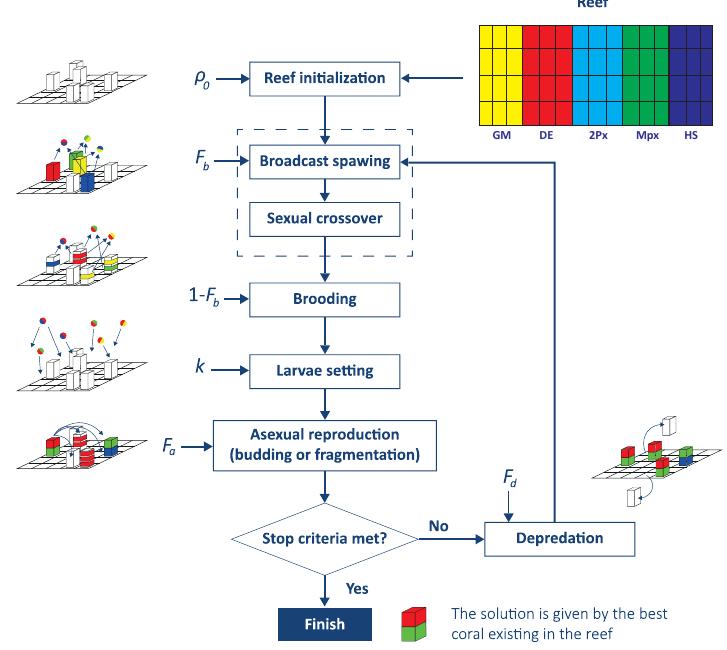
Figure 3. Flowchart of the CRO-SL